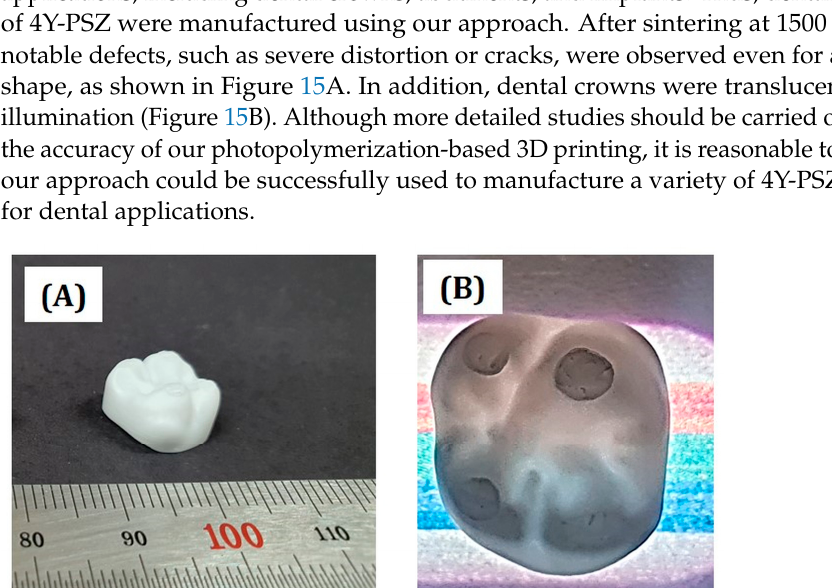
Figure 14. ( A ) Optical image of 4Y-PSZ disks sintered at various temperatures (1300 °C, 1400 °C, and 1500 °C) placed on colored lines and ( B ) their translucency (TP) and contrast ratio (CR) values (* p < 0.05).